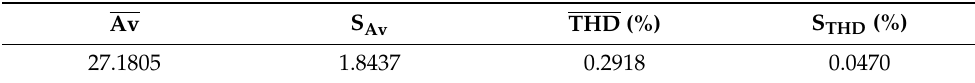
Table 3. Average and standard deviation values obtained from the Monte Carlo analysis in the initial design.